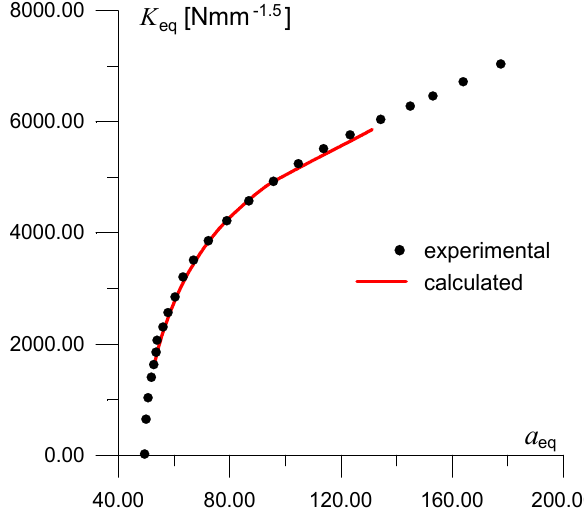
Figure 10: Comparison between calculated and experimental